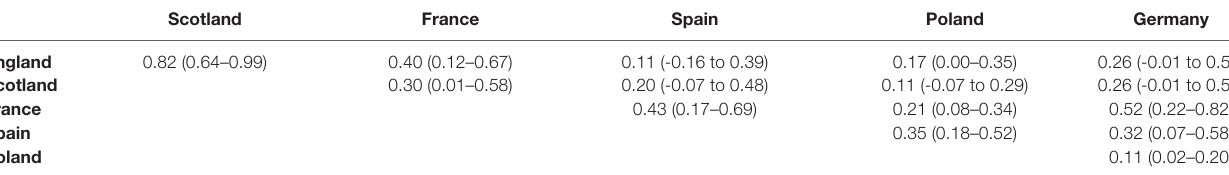
TABLE 4 | Agreement in reimbursement status between countries for oncologic drugs.